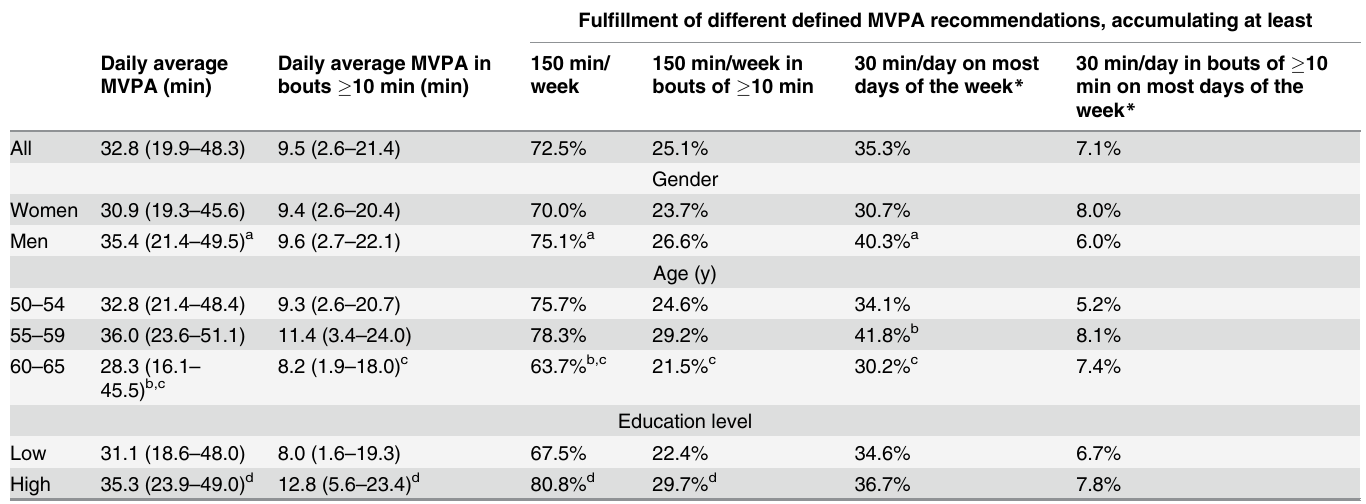
Table 5. Time in MVPA and fulfillment of different defined MVPA recommendations among all study participants and in subgroups. Ful fi llment of different de fi ned MVPA recommendations, accumulating at